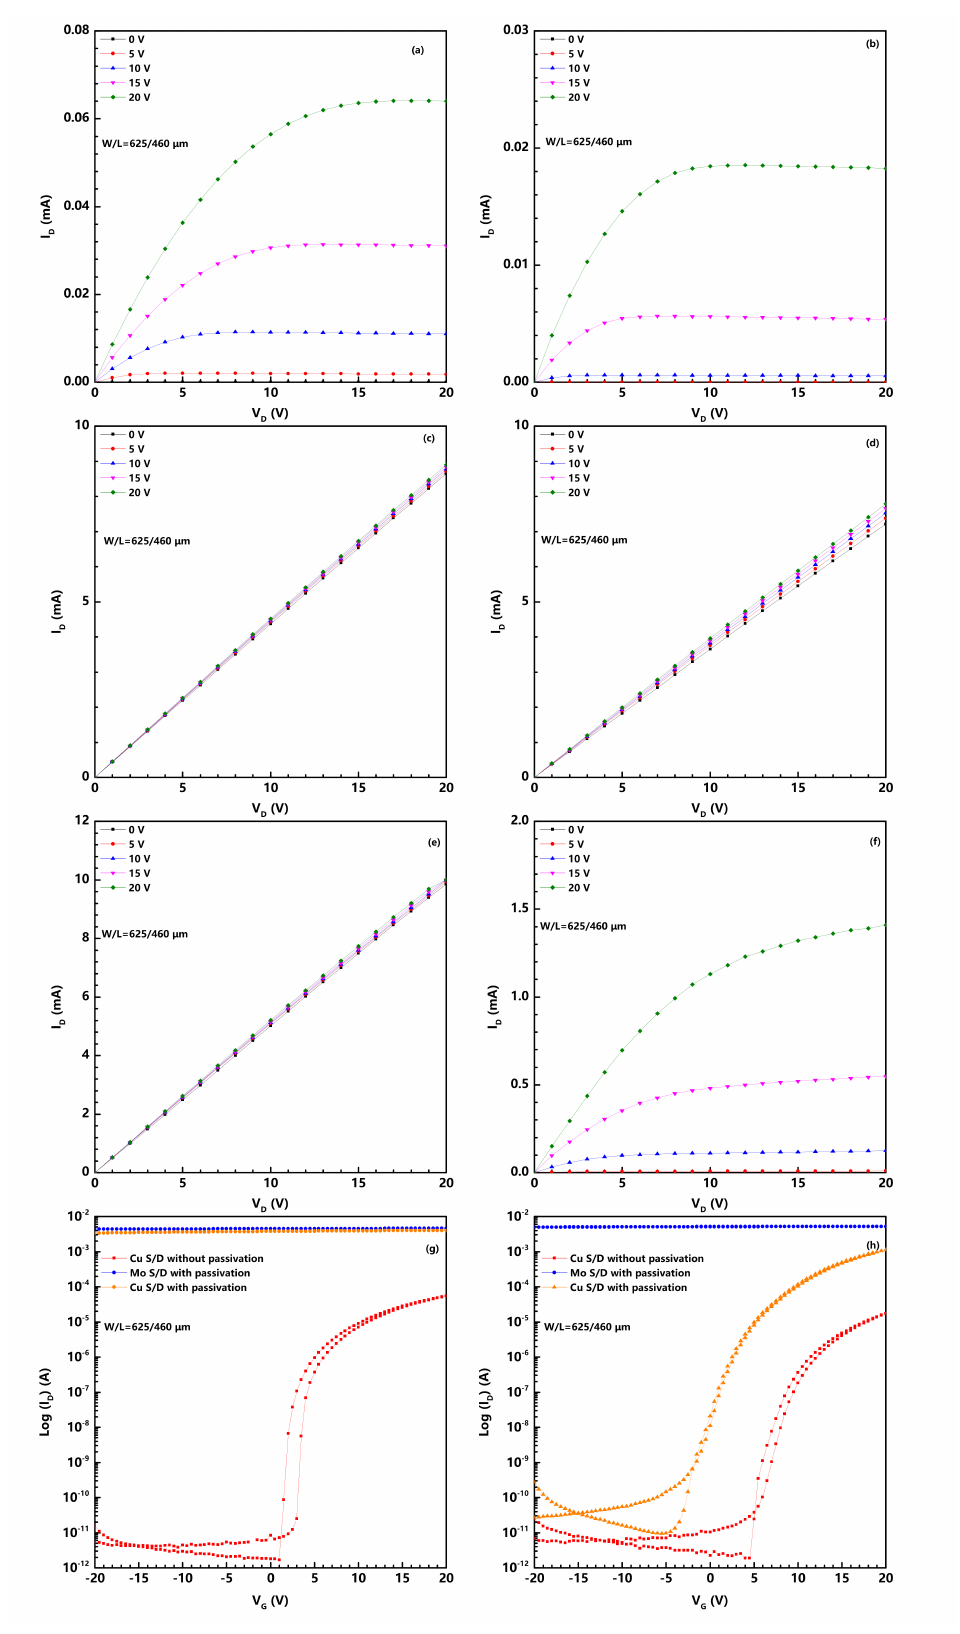
Figure 1. ( a – f ) output characteristics for S1, S2, S3, S4, S5 and S6 devices, respectively; transfer curves of a-IGZO TFTs ( g ) before post-annealing and ( h ) after post-annealing measured at drain voltage ( V D ) equal to 10.1